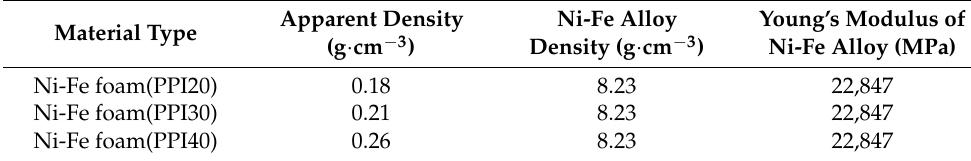
Table 1. Material Properties of Ni-Fe Foam.